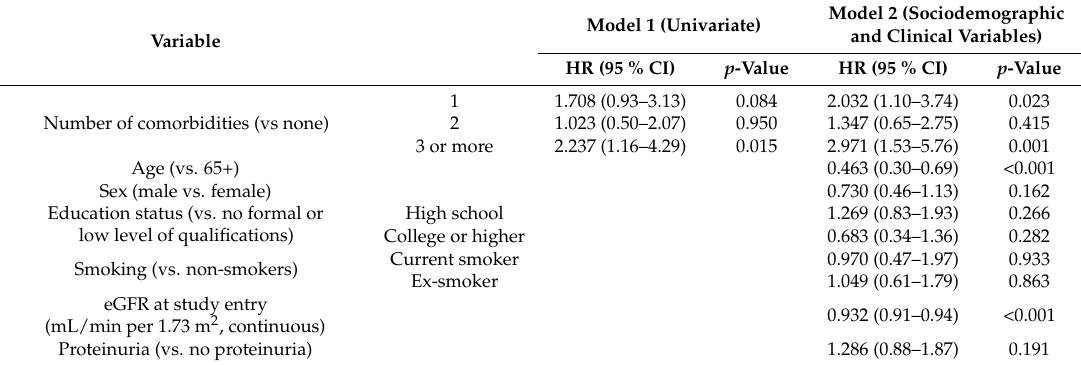
Figure 2. A number of comorbidities ≥ 3 was associated with a faster decline of the renal function in patients with stage 3–5 CKD. Table 4. Cox proportional hazards models for dialysis initiation in the study population.